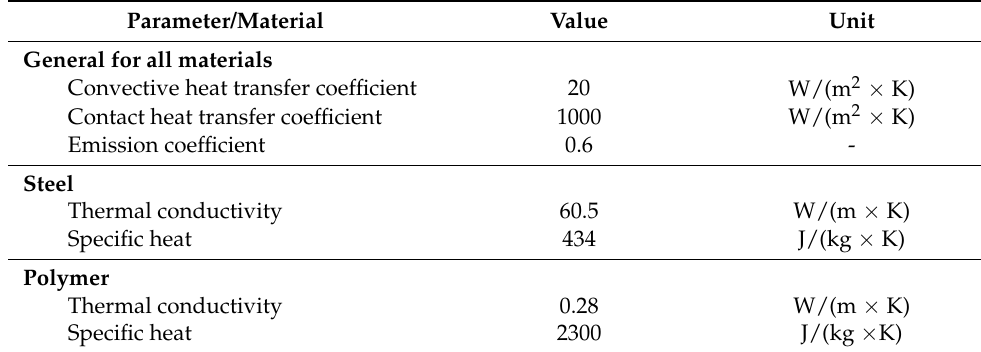
Figure 3. The overview of the model geometries: ( A ) shunt current-assisted RSW; ( B ) induction heating-assisted RSW; and ( C ) ultrasonic-assisted RSW. Table 3. Selected boundary conditions and physical